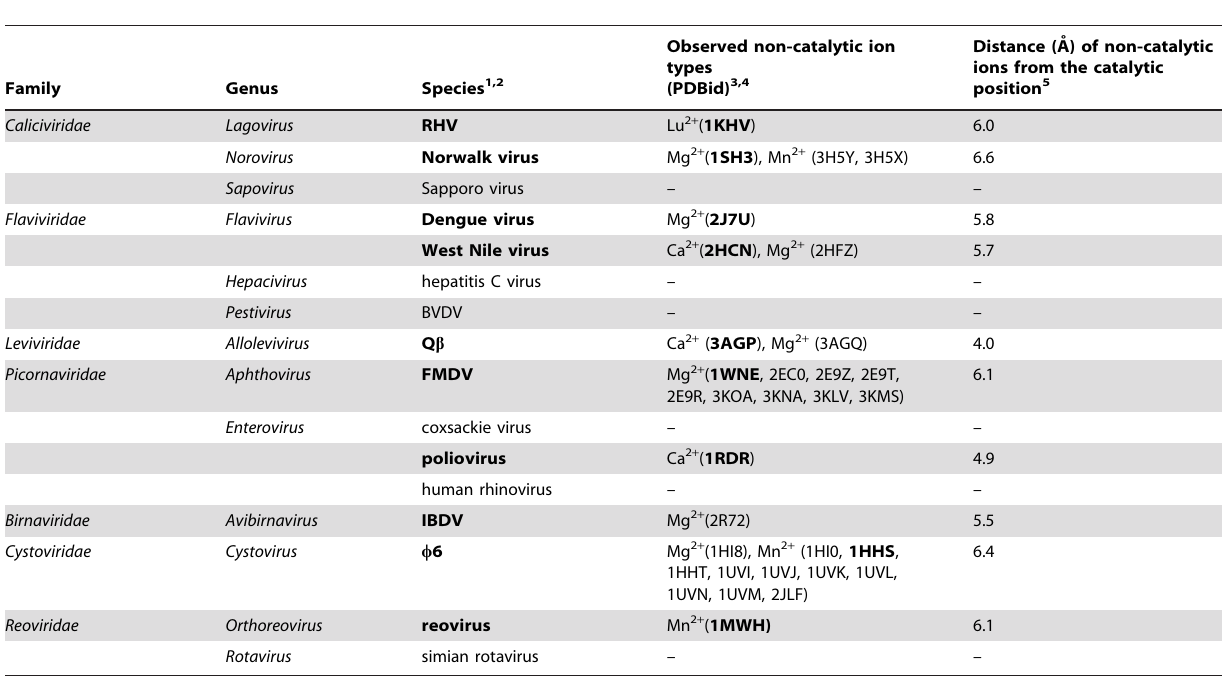
Table 2. A list of virus species having RdRp structures in the PDB, observed non-catalytic ion types, and distances of non-catalytic ions from the catalytic